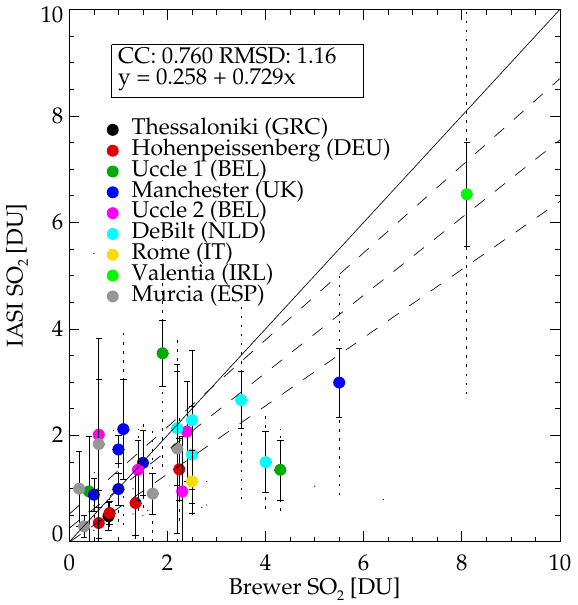
Figure 5. Scatter plot of IASI SO 2 measurements, averaged within a distance of 200km from the ground station, vs. the daily SO 2 column amount, measured from Brewer spectrometers. Different colours correspond to different Brewer ground stations. Black error bars are the IASI average errors; dotted error bars are the standard deviation of the IASI data within the selected distance. Black lines represent the ideal line y = x ; dotted lines are the best fits with er- ror in the best fit. The legend box shows the correlation coefficient (CC), root mean square difference (RMSD) and the best fit